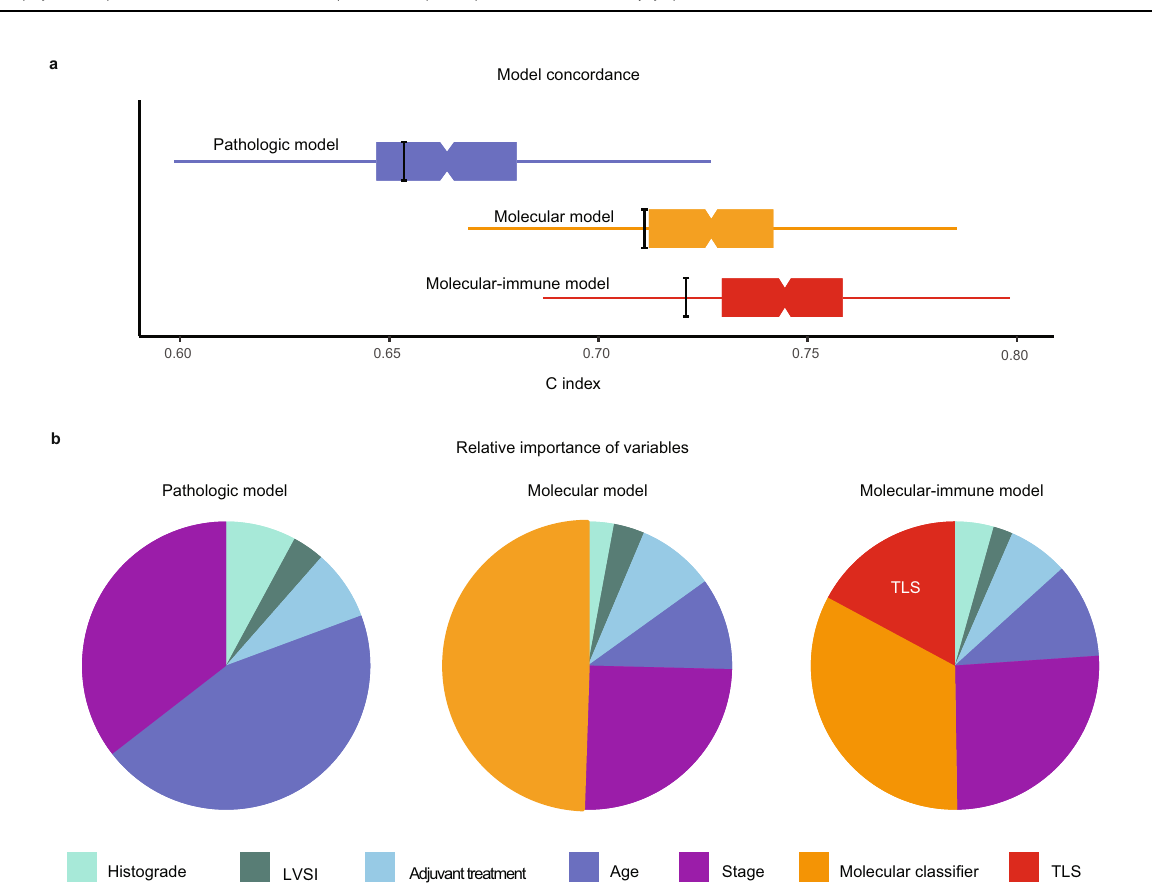
Three Cox proportional hazards models to showing impact of respectively clinicopathological factors, clinicopathological + molecular factors, and clinicopathological + molecular factors + presence of tertiary lymphoid structures on time to recurrence. Covariates were pre-speci fi ed according to Léon-Castillo et al. (J Clin Oncol, 2020) 2 . The addition of the molecular classi fi er to the pathologic model was associated with an improvement in model fi t evidenced by: (i) reduction in Akaike ’ s information criterion (AIC) 1244.968 vs. 1202.158, (ii) increase in model concordance (C index 0.655 vs. 0.714, and (iii) likelihood ratio test for comparison of nested models p = 1.43×10 − 10 . Likewise, the addition of TLS presence improved model fi t: (i) AIC 1202.158 vs. 1194.242, (ii) C index 0.714 vs. 0.729, (iii) likelihood ratio test for nested models p = 0.0016.